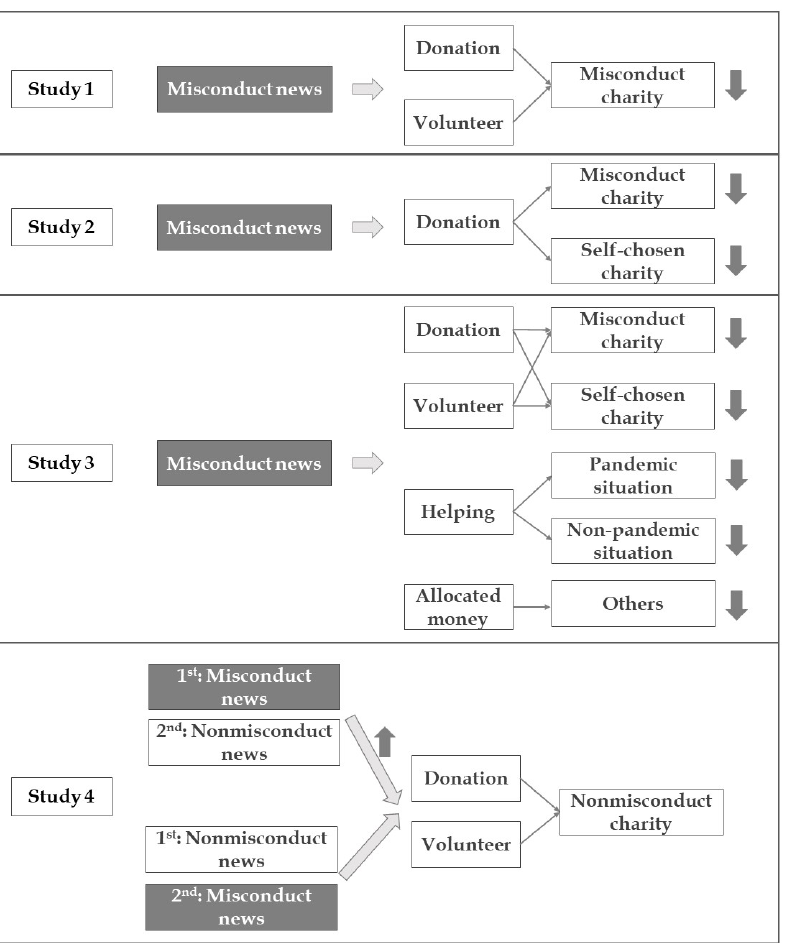
Figure 1. A summary diagram of Study 1 to Study 4. Participants read news on charity misconduct (dark) and news on charity nonmisconduct and reported their willingness to help in different